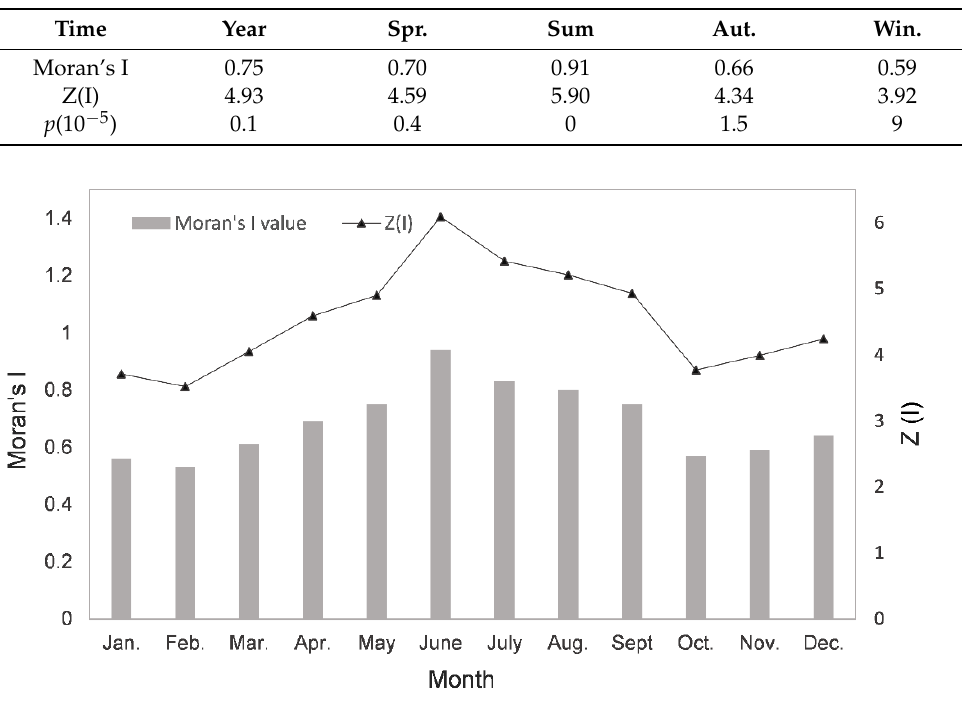
Figure 2. Spatial autocorrelation value of ozone monthly average concentration of HCUA.